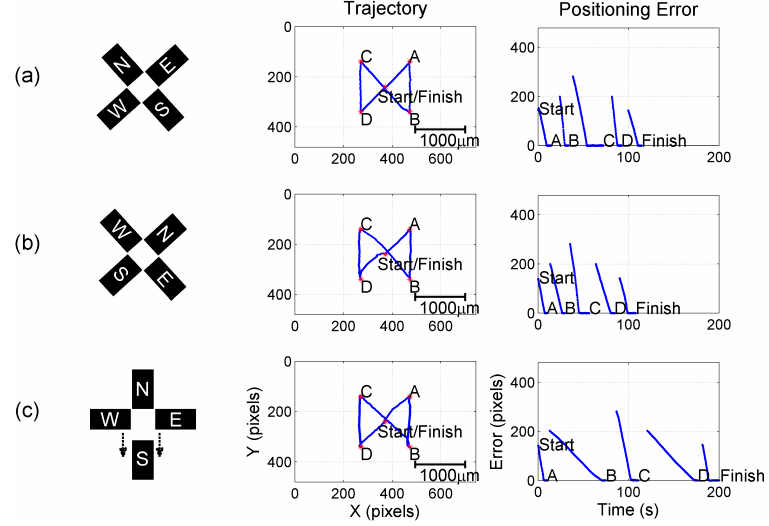
Figure 7. Point-to-point control of three different microrobot devices using the same algorithm and initial conditions: ( a ) “S”, ( b ) “bar” and ( c ) “wedge” shaped devices. These